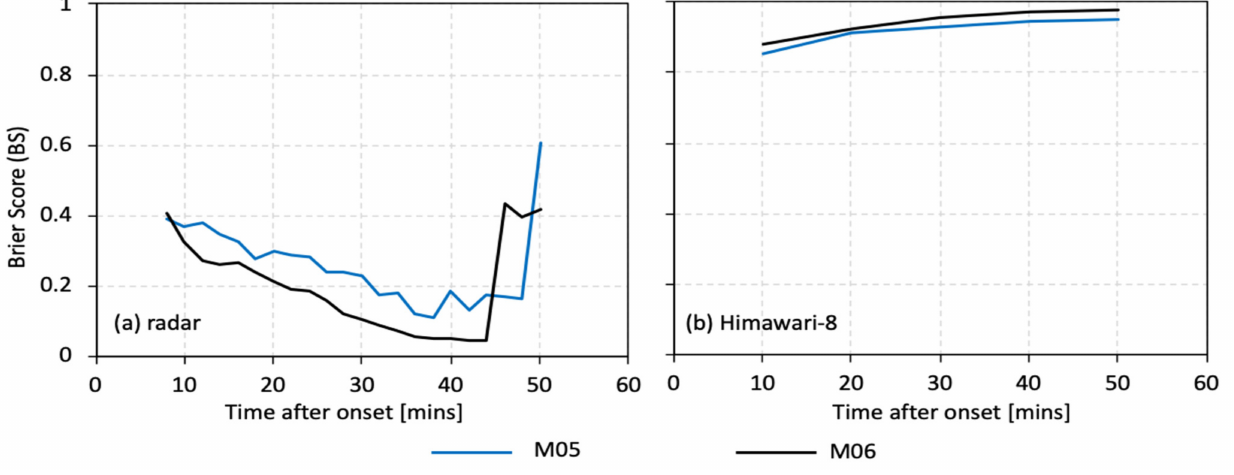
Figure 9. Brier score of tephra plume tracking by mean EPS of M05 and M06 based on the pair analysis with ( a ) radar and ( b ) Himawari-8. Each EPS was generated using six